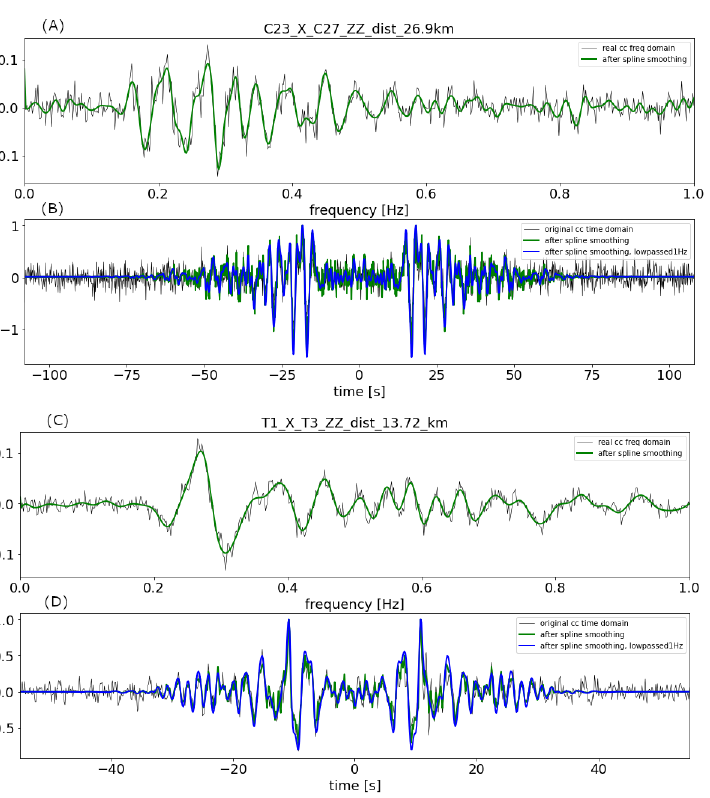
Figure 6. ( A ) Real part of the cross-correlation of station pair C23–C27 with an inter-station distance of 26.9 km in the frequency domain. ( B ) Cross-correlation of station pair C23–C27 in the time domain. ( C ) Real part of the cross-correlation of station pair T1–T3 with an inter-station distance of 13.72 km in the frequency domain. ( D ) Cross-correlation of station pair T1–T3 in the time domain. Smoothing (green line) helps to reduce the effect of spurious zero crossings [49]. The smoothed cross-correlations in the time domain (green and blue) are symmetric around time zero since the imaginary part of the frequency domain cross-correlation was set to zero prior to the inverse Fourier transform. According to the data analysis, the maximum range of frequency set to 1